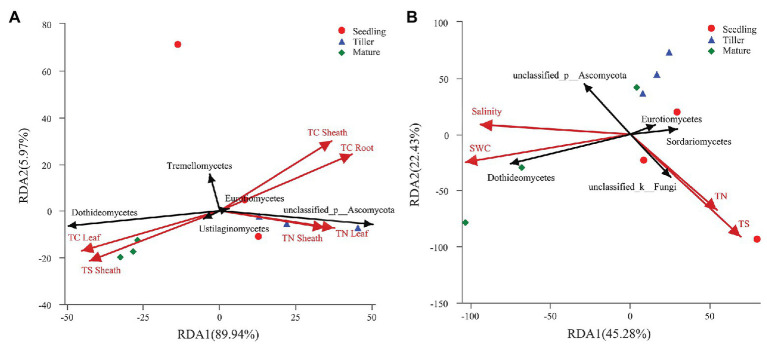
Redundancy analysis (RDA) of the top five fungal classes and leaf or soil characteristics. Phyllosphere and rhizosphere fungal communities are shown in (A,B), respectively. The values of axes 1 and 2 are the percentages explained by the corresponding axis.